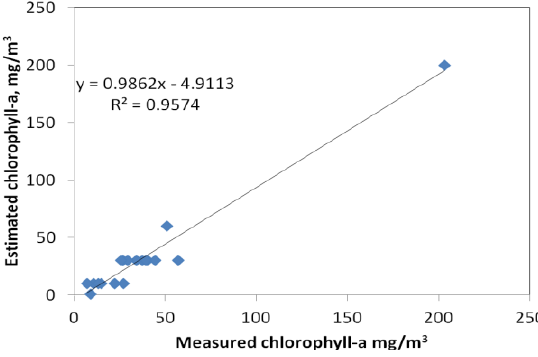
Figure 1. Correlation between the chlorophyll concentration measured from water samples and the chlorophyll concentration estimated using a modelled spectral library and Spectral Angle Mapper procedure.